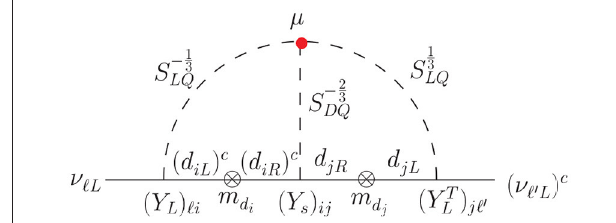
Frontiers in Physics |